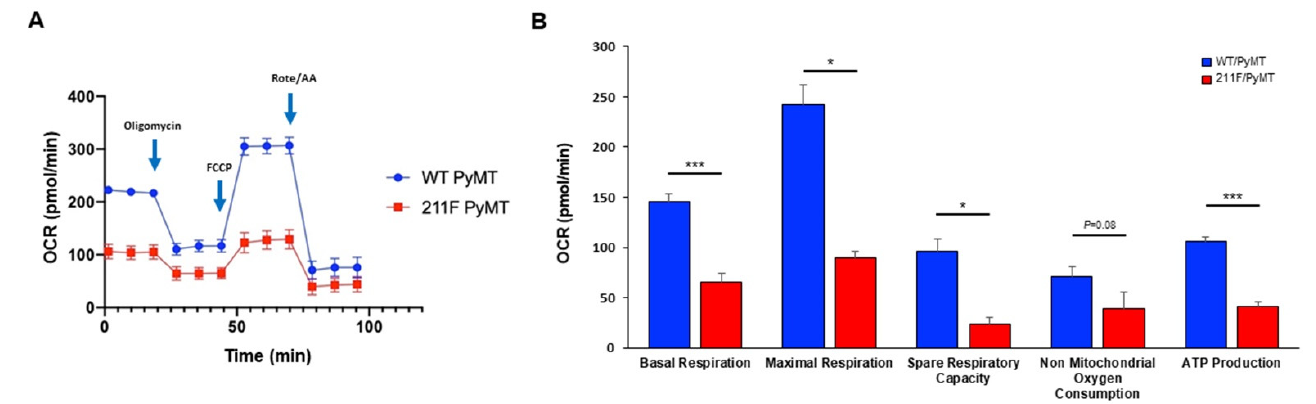
Figure 5. Mitochondrial activities regulated by PCNA Y211 phosphorylation. ( A ), OCR was deter- mined by the Agilent Seahorse XFe24 Extracellular Flux analyzer for the PyMT tumor − derived cells of the indicated genotypes in the presence of the indicated metabolic inhibitors to determine basal, maximal, spare respiratory activities, as well as non-mitochondrial oxygen consumption and ATP production. ( B ), OCR measurements. Bar, standard deviation. *, p < 0.05; ***, p < 0.005 as determined by Student’s t − test.